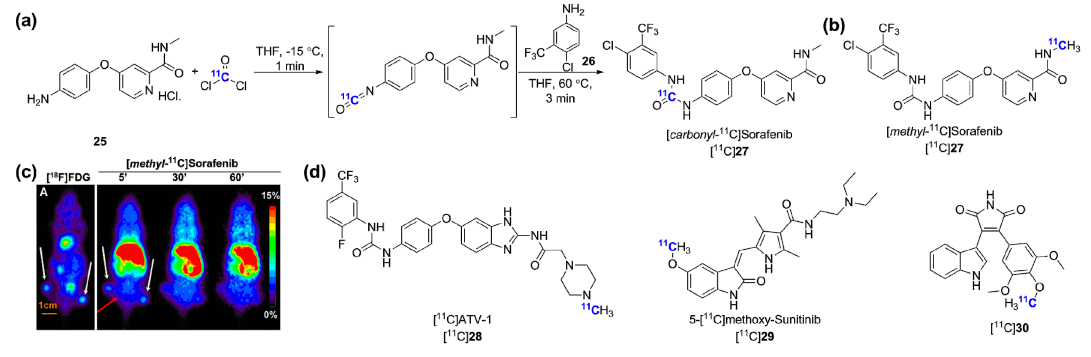
Figure 9. Other radiolabeled multikinase inhibitors targeting VEGFRs. ( a ) Radiosynthesis of [ carbonyl - 11 C]sorafenib; ( b ) Chemical structure of [ methyl - 11 C]sorafenib; ( c ) [ 18 F]FDG ( A ) and [ methyl - 11 C]sorafenib coronal PET images of RXF393 tumor bearing mice (reprinted from [115] with permission from Elsevier); ( d ) Chemical structures of additional recently radiosynthesized multikinase inhibitors targeting VEGFRs.